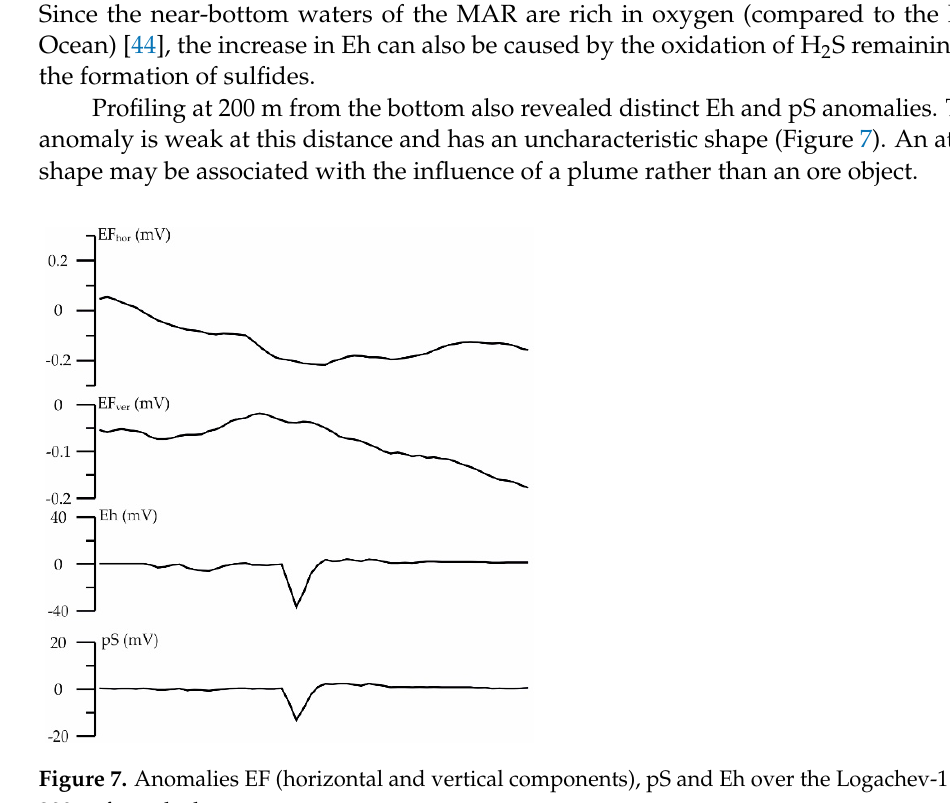
Figure 6. The structure of the geophysical (( a ) EF) and geochemical (( b ) Eh and E H2S ) anomalies above the active hydrothermal structure Irina-2 (Logachev field) [38].